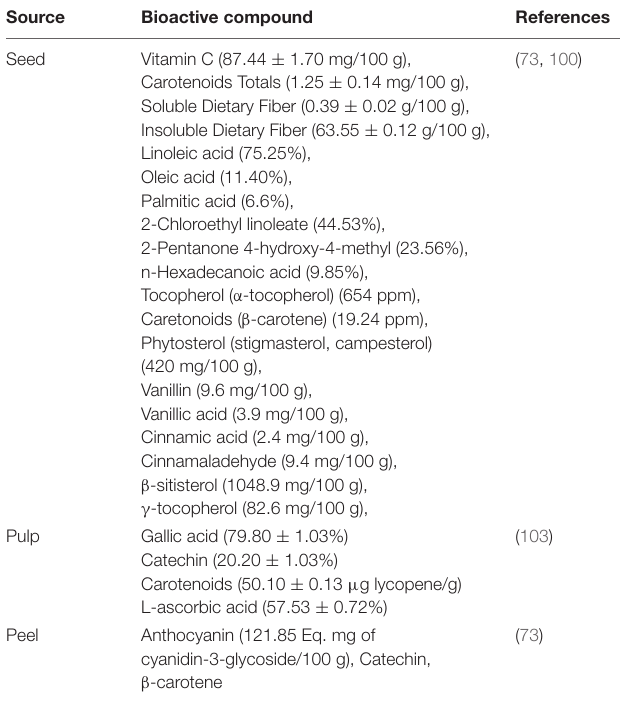
TABLE 4 | Different bioactive compounds reported in seed, pulp, and peel of